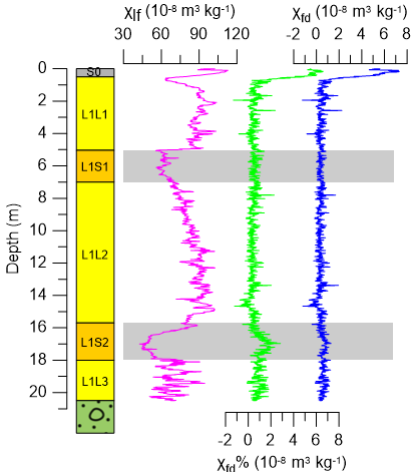
Figure 2. Lithology and magnetic susceptibility characteristics ( χ lf , χ fd and χ fd %) of the NLK